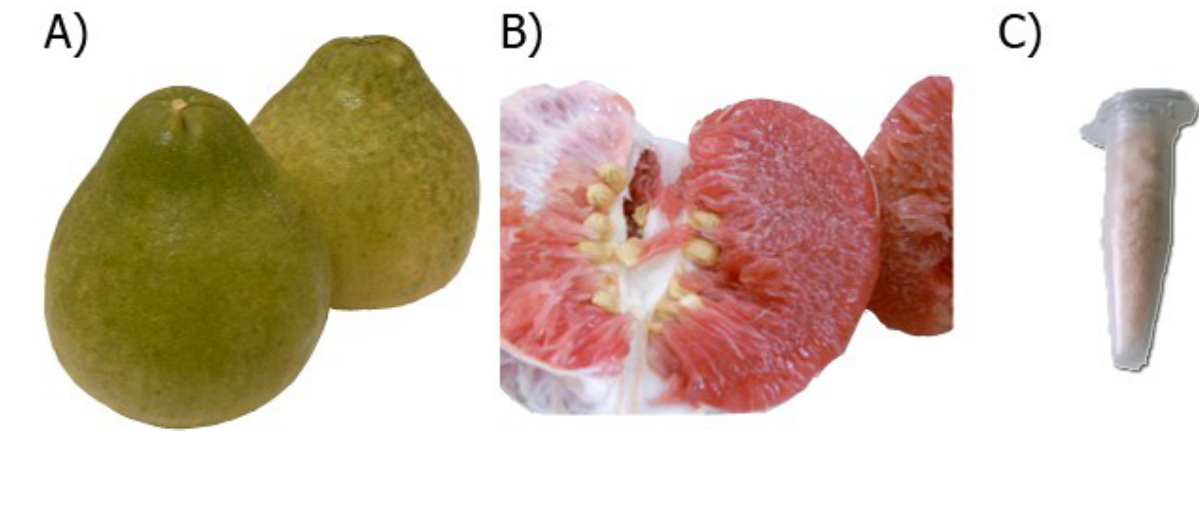
Figure 2. Citrus maxima Merr. (pummelo) fruits var. Tubtim-Siam. ( A ) general appearance; ( B ) the reddish inner flesh; ( C ) pinkish freeze-dried